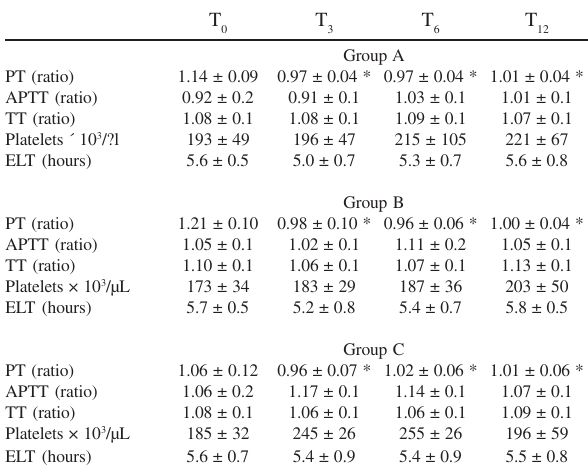
through T ) in patients 0 12